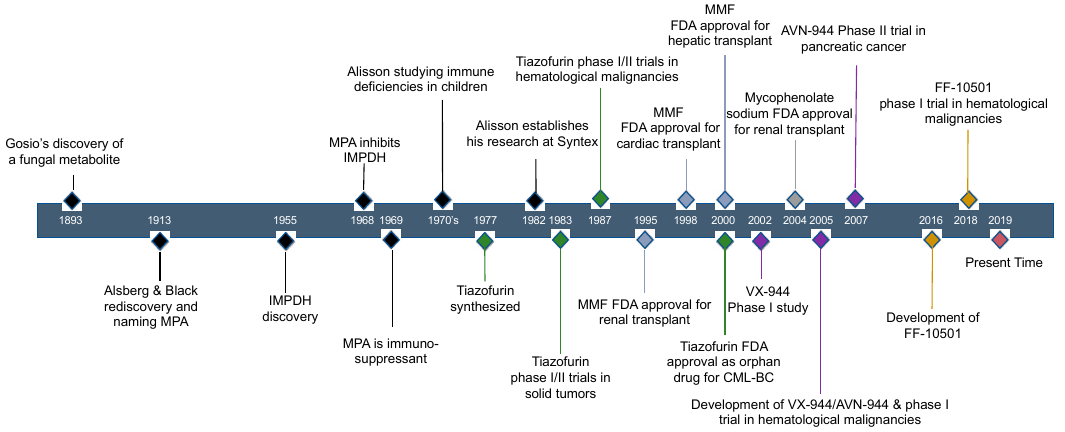
Figure 1. Timeline of events in the history of MPA and other IMPDH inhibitors.